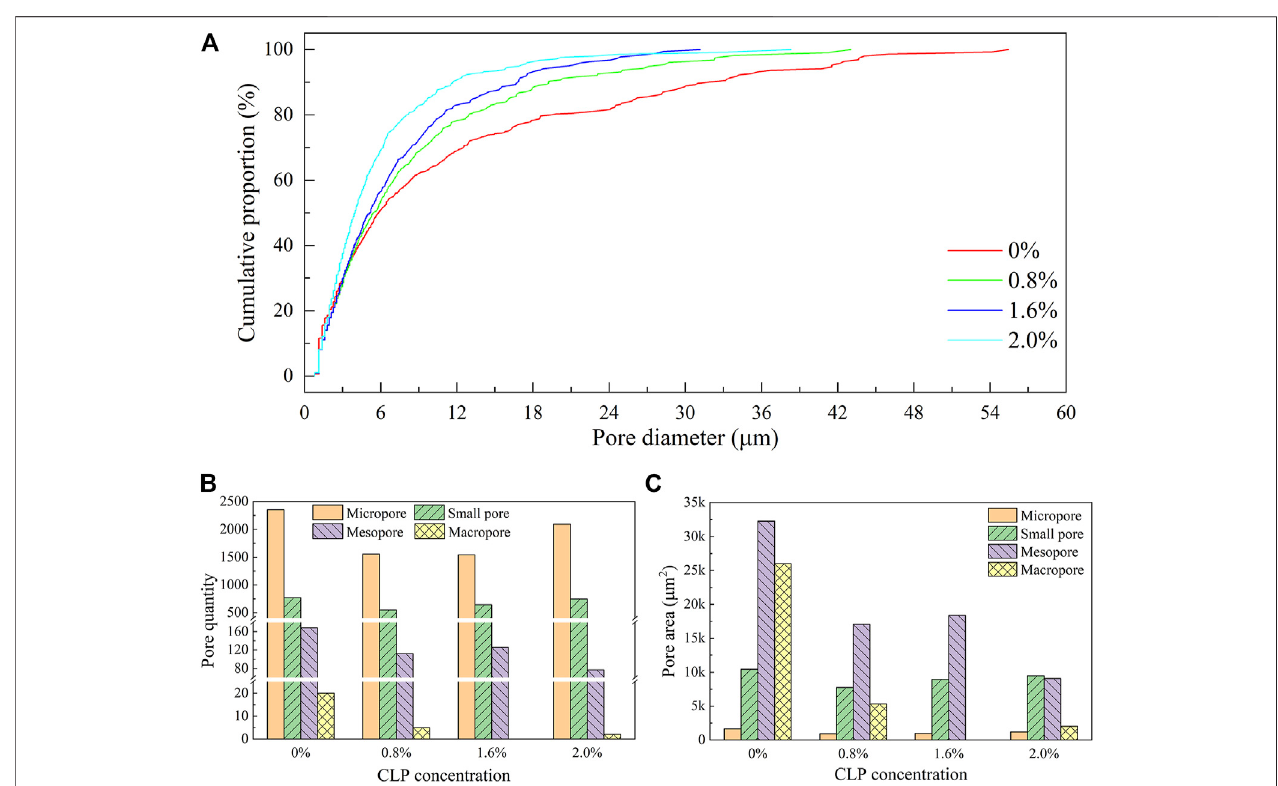
FIGURE10|(A) Cumulativeporedistributionpercentage ofloesstreatedwithdifferentcross-linkedpolymerconcentrations.Porequantity (B) andtotalarea (C) of loess treated different cross-linked polymer (CLP) concentrations.